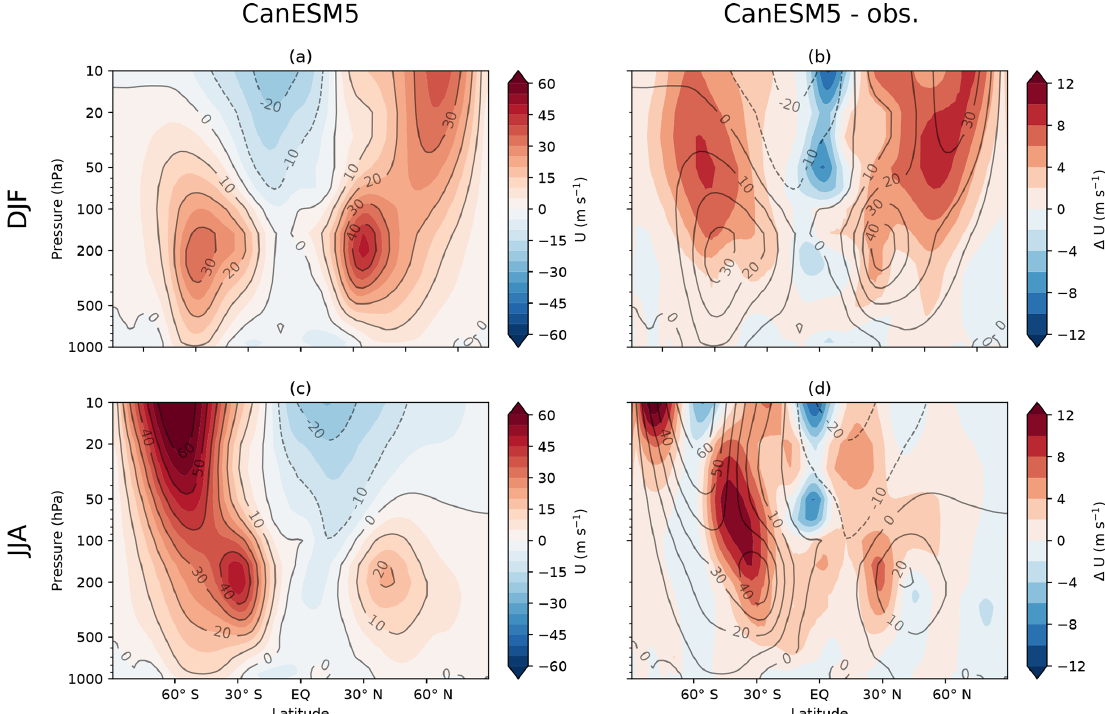
Figure 10. Zonal-mean zonal winds (a, c) and bias relative to ERA5 (b, d) over 1981–2010 for the DJF (a, b) and JJA (c, d) seasons.